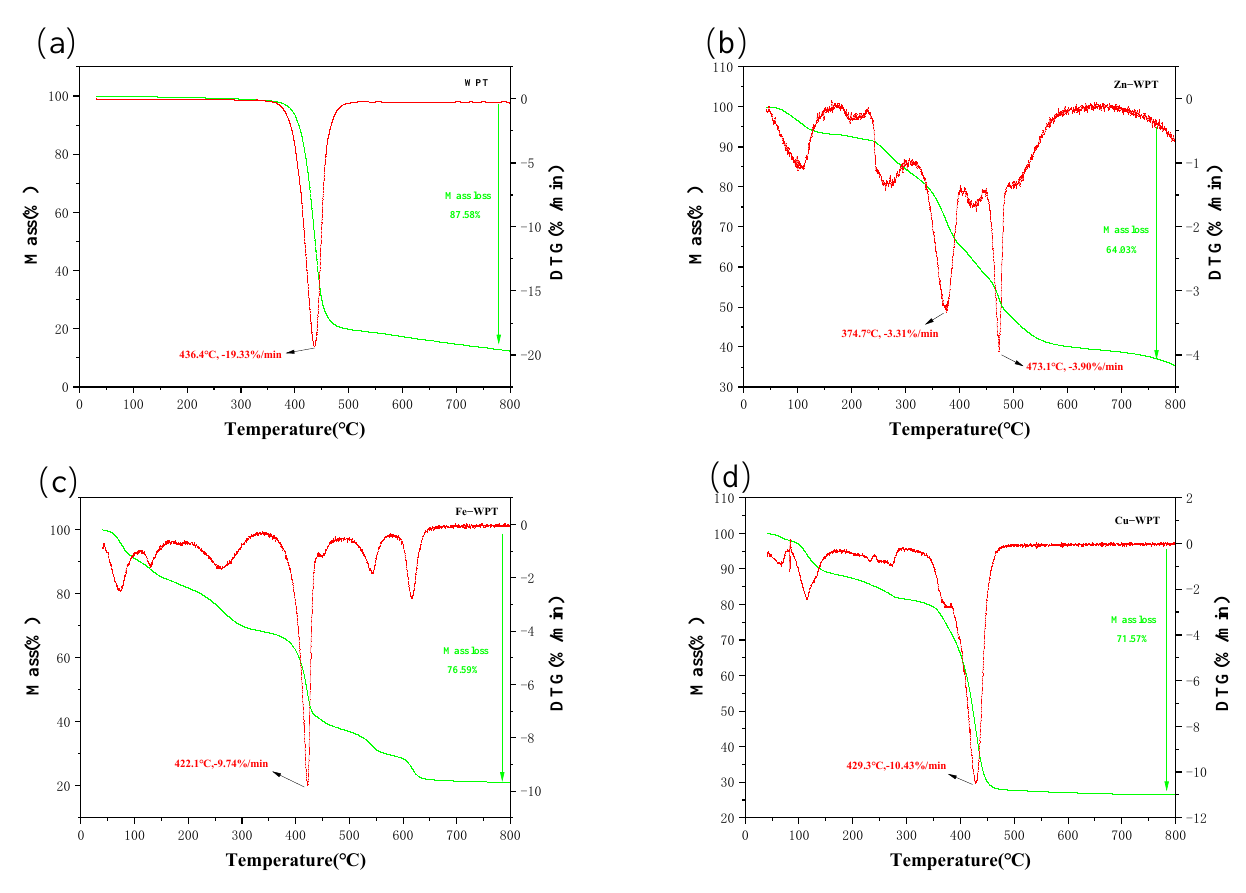
the DTG curve at 473 ◦ C, with a mass loss of 37.9%. In the third stage (600~800 ◦ C), the residual solid in the second stage was further pyrolyzed and carbonized to form a stable structure and released volatiles, with a mass loss rate of 5%.